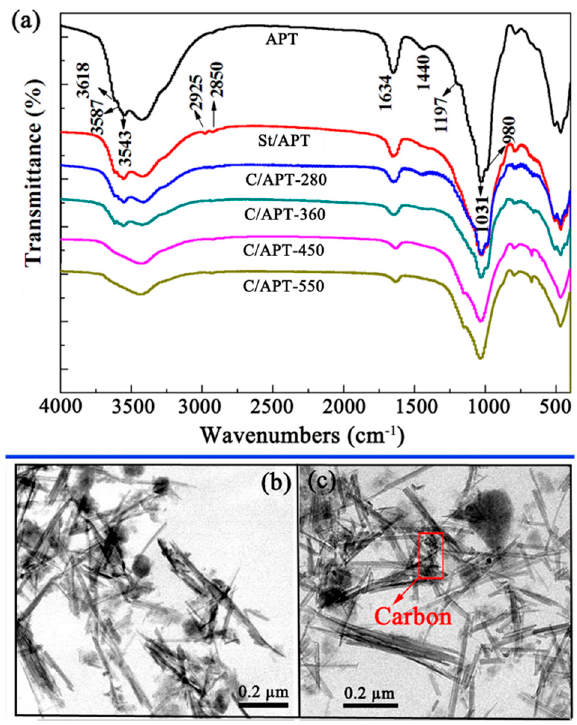
Figure 1. FTIR spectra of APT, St/APT precursor and the C/APT adsorbents prepared at different temperatures ( a ); and TEM images of APT ( b ) and C/APT-280 ( c ).